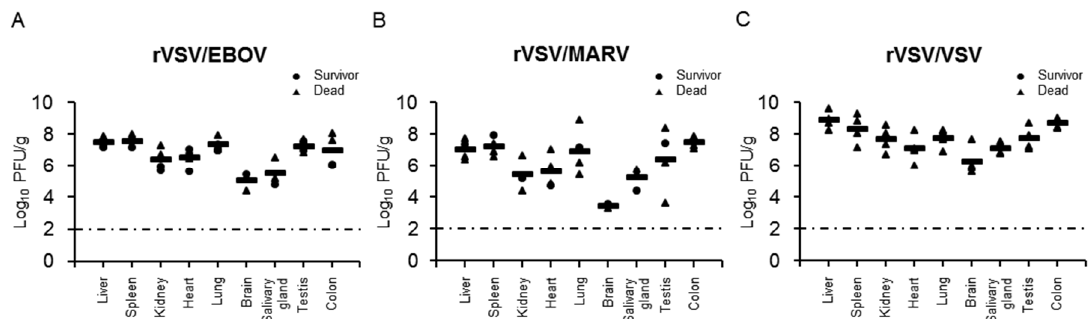
Figure 3. Virus titers in hamsters infected with rVSVs. Four hamsters in each group were infected i.p. with 10 7 PFU of ( A ) rVSV / EBOV, ( B ) rVSV / MARV, or ( C ) rVSV / VSV. Thirty-six hours after virus inoculation, tissue samples were collected and used for virus titration in plaque assays. Two of four rVSV / EBOV-infected, three of four rVSV / MARV-infected, and three of four rVSV / VSV-infected animals already succumbed at the sampling time point. Each symbol represents the value of an individual hamster. The bars represent the means for the infected hamsters. The broken lines indicate the detection limit (<2.0 log 10 PFU/g).